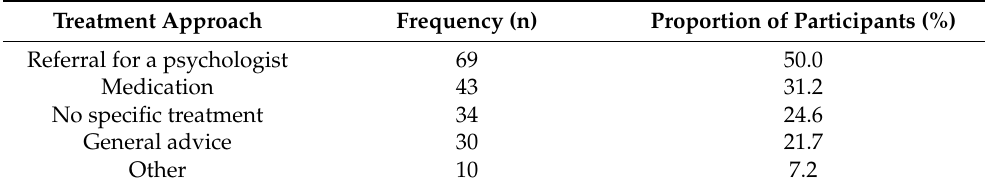
Table 3. Preferences for treatment approach at first appointment with GP.